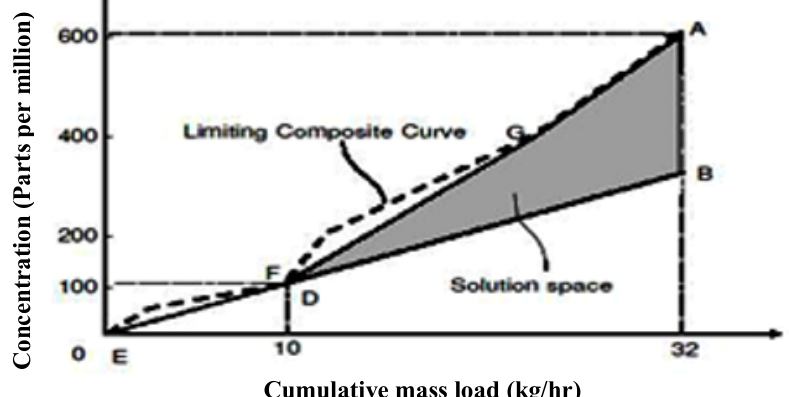
Figure 2. Cumulative mass load versus concentration resulted from Kuo and smith (1998)